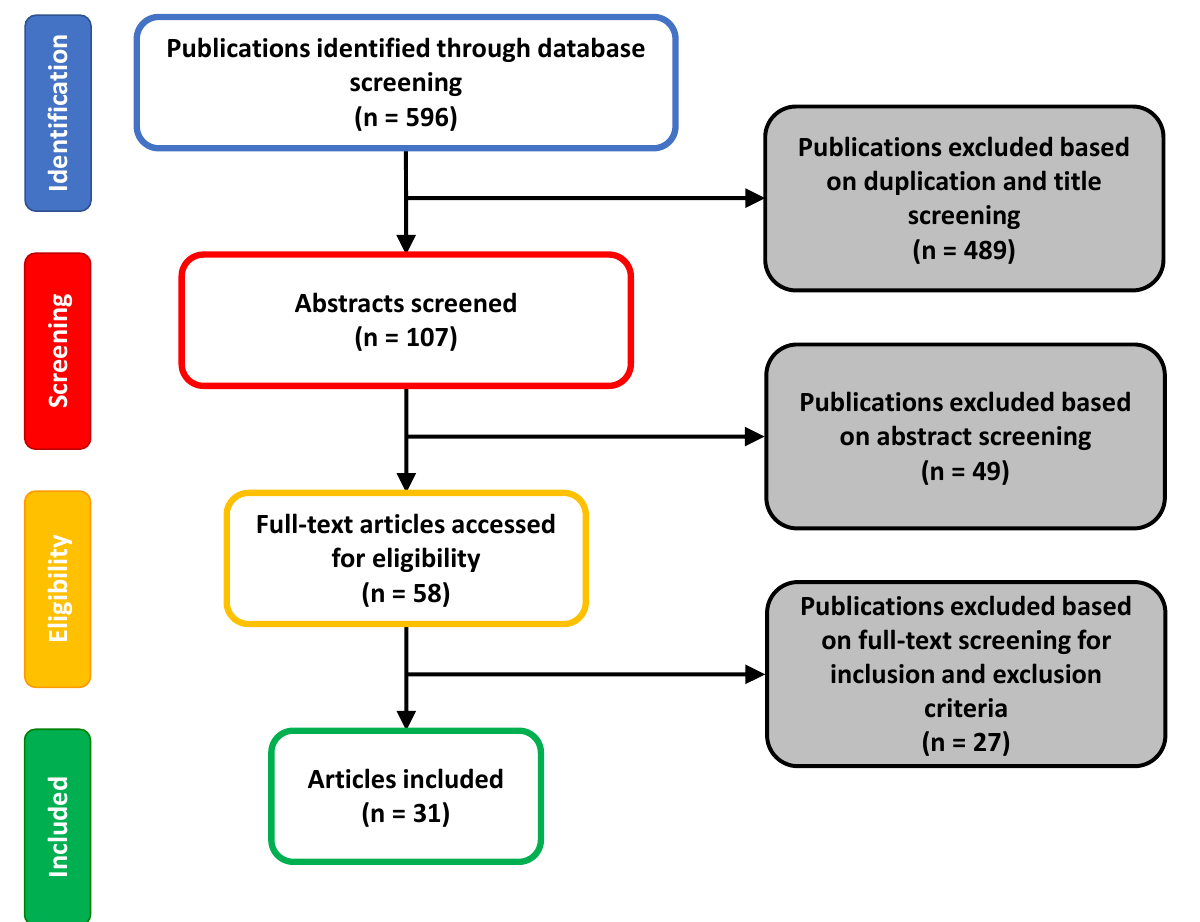
Figure 1. Strategy of the literature review process. Table 1. Biomechanical aspects of pole